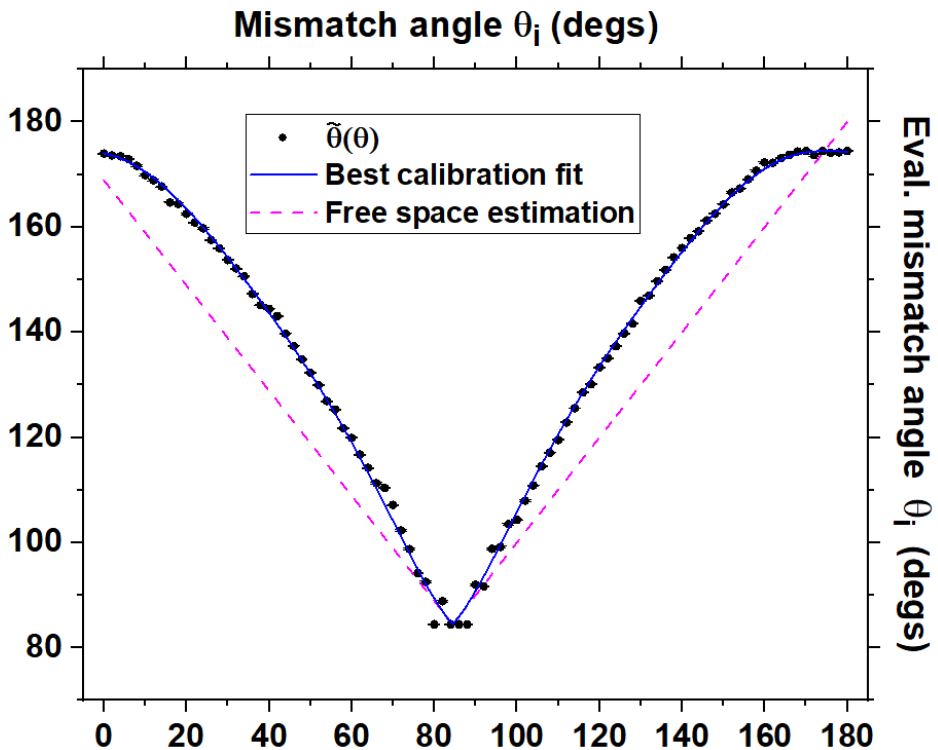
Figure 3. ˜ θ ( θ ) (black dots), its best fit with calibration curve from Equation (3) (blue straight curve), and the free space limit (dotted magenta